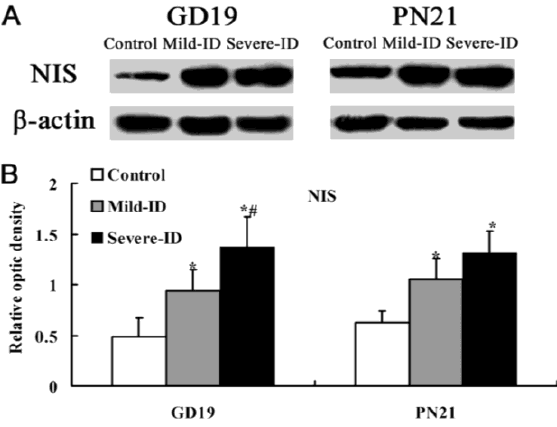
Figure 5. Up-regulated protein levels of NIS in the thyroid. The upper bands ( A ) depict representative findings for rats subjected to mild ID and severe ID. The lower bar graphs show the results of the semi-quantitative measurement of NIS ( B ) following mild ID and severe ID treatment. The height of each bar represents the mean ±SD for the groups. At each time point, * compared to the control, p < 0.05; # compared to the mild ID, p < 0.05 (n = 5).